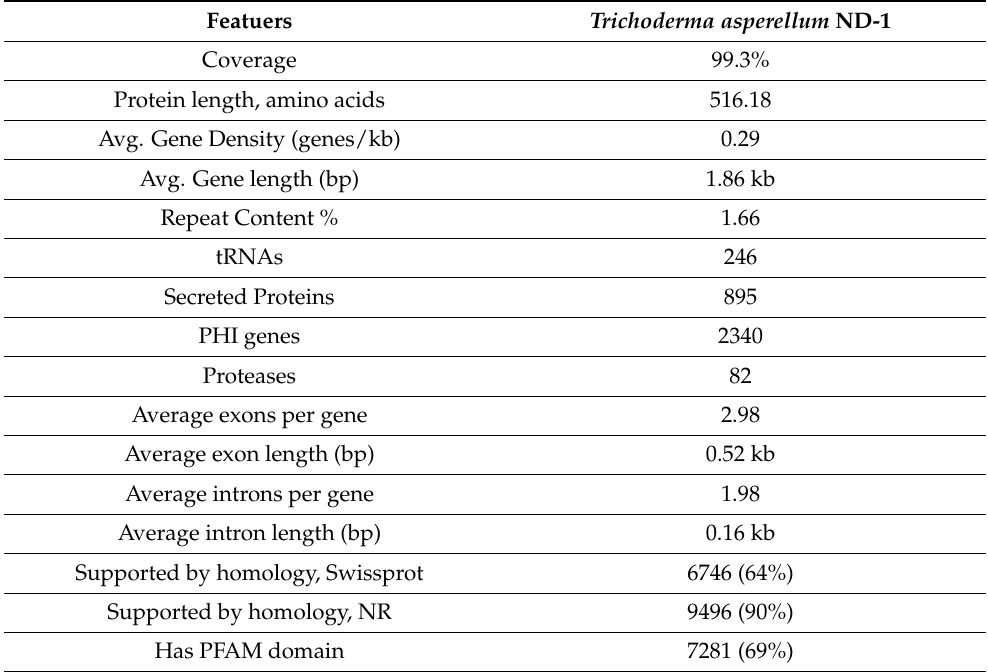
Table 1. Genome assembly and annotation statistics of T. asperellum